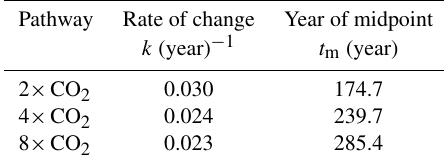
Table 1. Parameter values for logistic CO 2 pathways.